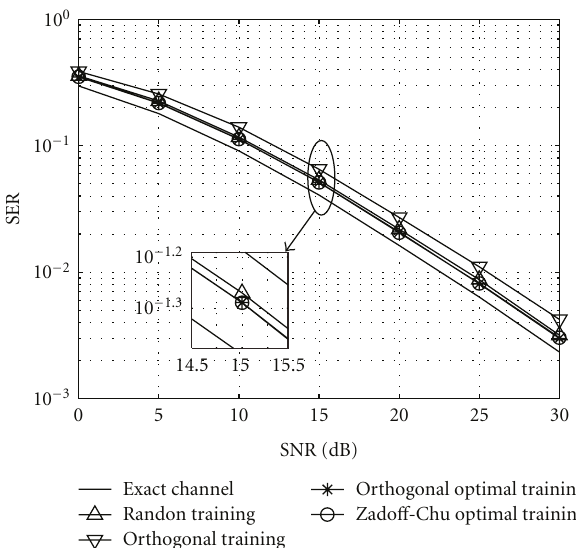
Figure 2: SER performance for di ff erent